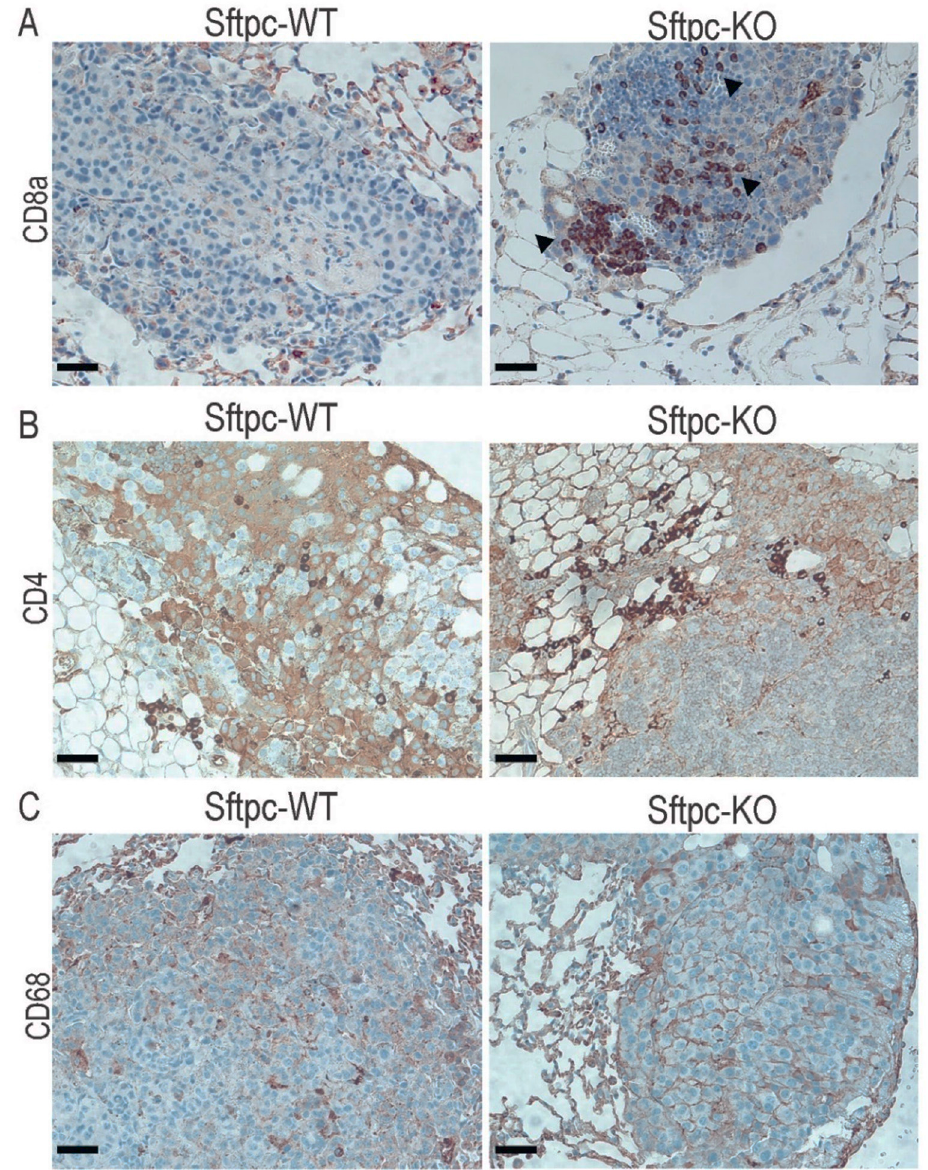
Figure 7. Immunostaining performed on Sftpc-WT and Sftpc-KO lung sections. Five-micrometer lung sections were stained for ( A ) CD8a, Sftpc-KO mice presented a higher CD8+ T cell infiltration (black arrows); ( B ) CD4, both groups presented nodules with sparse CD4+ infiltration; and ( C ) CD68, no infiltration of CD68 + cells was observed. Scale bars represent 200 μ m (10× magnification).